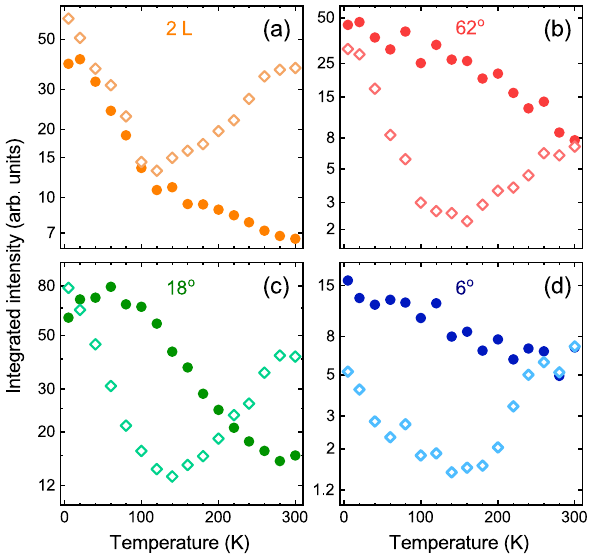
Figure 6. Temperature evolution of the integrated intensities of the (solid circular points) direct- and (open diamond points) indirect-related emissions extracted from PL spectra measured on MoS 2 : ( a ) bilayer (2 L) and selected homobilayers with twist angles of ( b ) 62 ◦ , ( c ) 18 ◦ and ( d ) 6 ◦ . Note that the vertical scales are